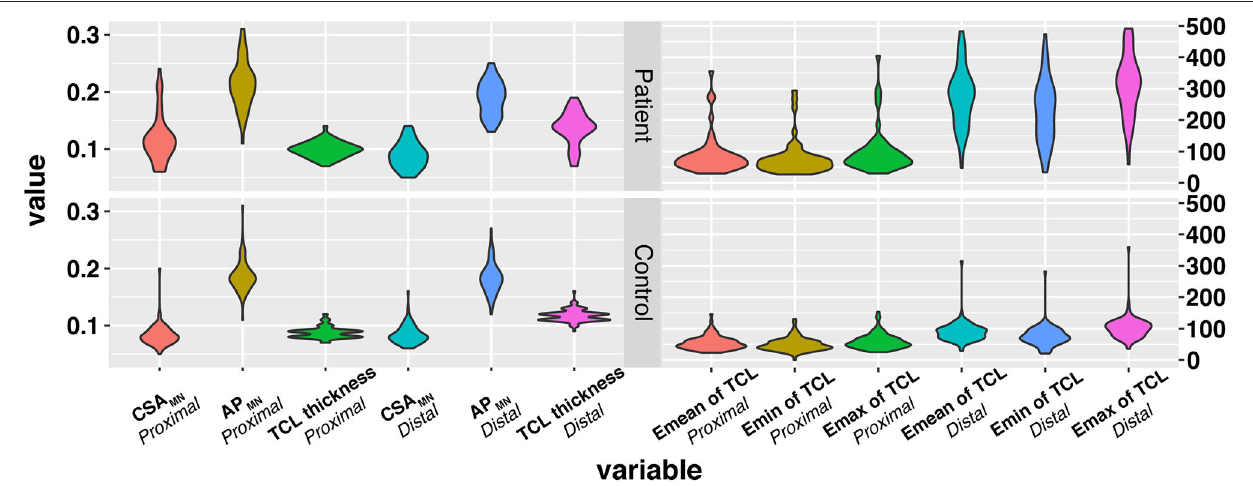
FIGURE 2 | The distribution of variables in the three groups. The x -axis represents variables, and the y -axis represents the values of variables. The wider bar represents the more distributed data. TCL, transverse carpal ligament; CSA, cross sectional area; MN, median nerve; SWE, Shear wave elastography.